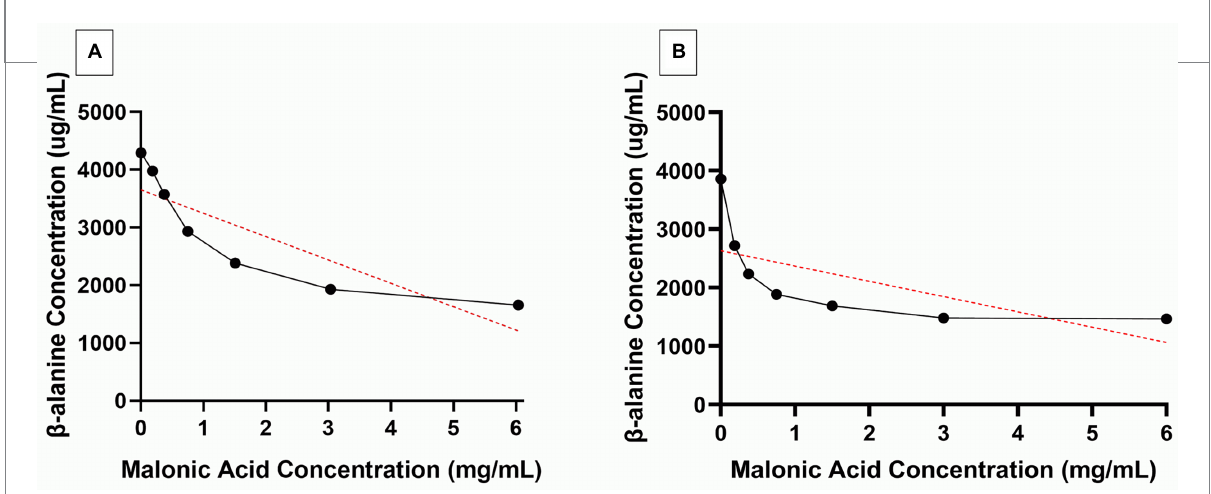
FIGURE 4 Selective inhibition of Helicobacter pylori aspartate α -decarboxylase (ADC) by malonic acid. β -alanine (Black line) produced from the action of (A) crude enzyme extract and (B) purified 6x-His tagged ADC, of Isopropyl β -D-1-thiogalactopyranoside induced Escherichia coli BL21/RecPl, in the presence of increasing concentrations of malonic acid. The red lines depict the correlation between the two variables.